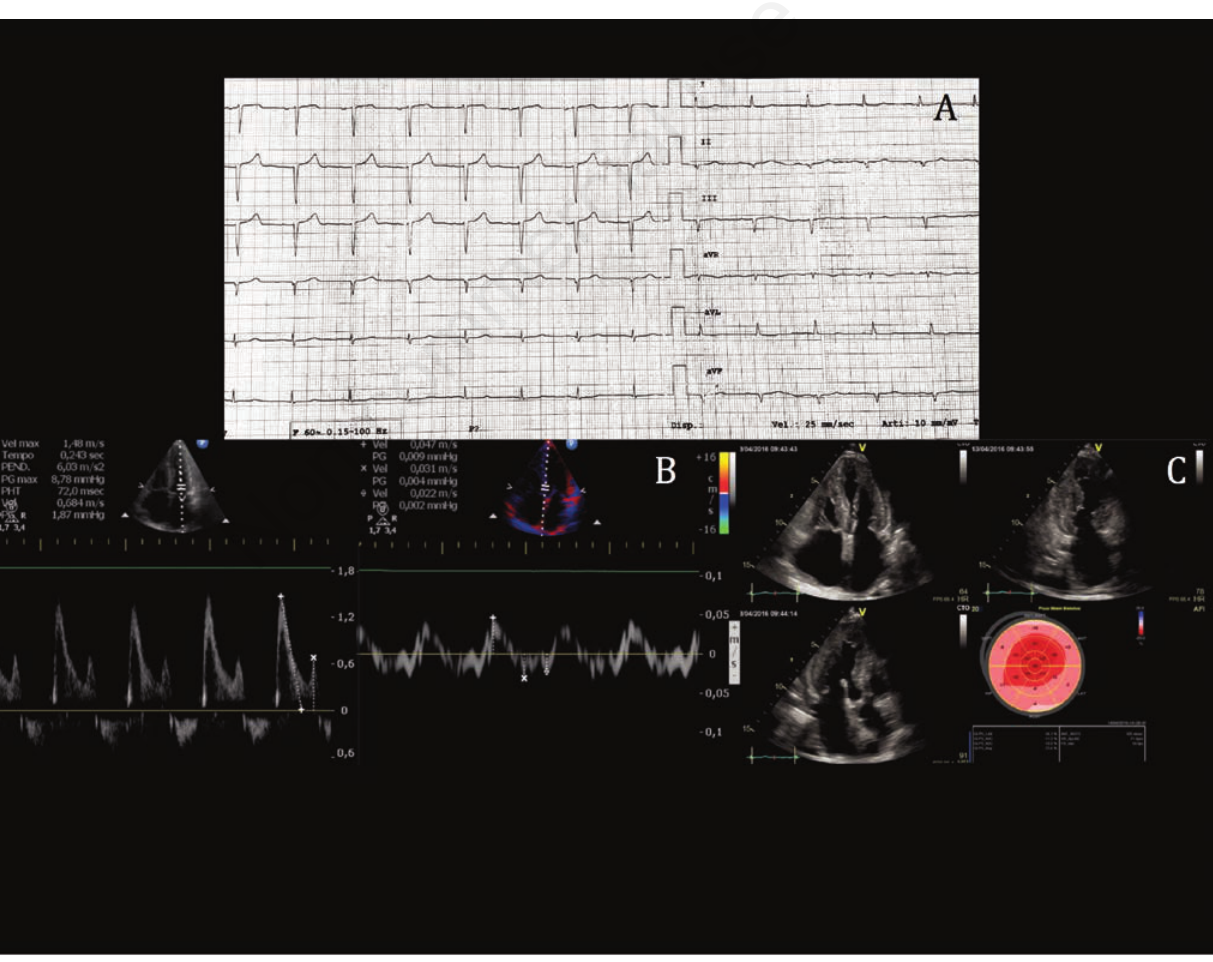
Figure 3. A) ECG showing a pseudo-infarct pattern; B) Transthoracic echocardiography showing restrictive filling pattern at mitral inflow spectral Doppler signal and low systolic and diastolic peak velocities on tissue Doppler imaging; C) Apical sparing pattern showed on speckle tracking